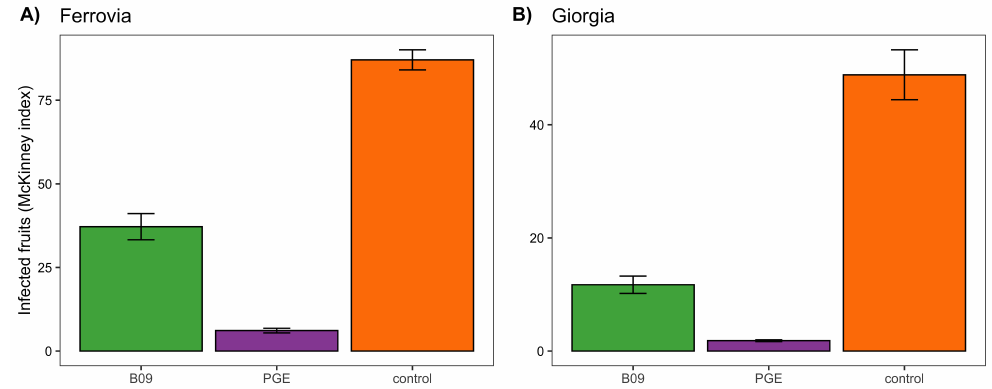
Figure 2. Efficacy of alcoholic extracts from bacterial isolates B01, B05, and B09 in reducing the incidence and severity (both accounted for using McKinney’s index) of fungal rot (mainly caused by Monilinia fructicola ) on two varieties of sweet cherries: ( A ) Ferrovia and ( B ) Giorgia. The extract is compared to a plant extract with strong antifungal activity (pomegranate peel extract, PGE) and an untreated control group.